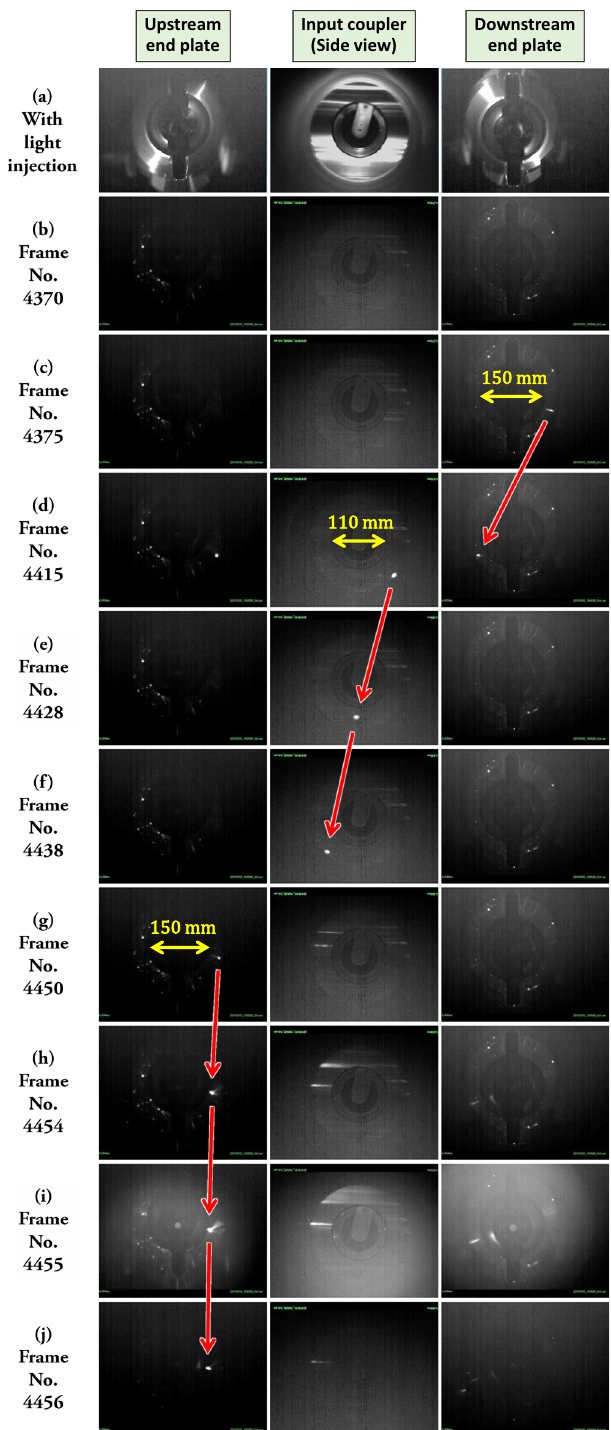
FIG. 19. First breakdown event accompanied by a flying bright object, which occurred at V c ¼ 0 . 88 MV, 15 ∶ 05 on March 15 in 2017. (a) Photographs showing the view of the high-speed cameras with light injected into the cavity for visualization. (b) – (j) Snapshots synchronized among the three high-speed cameras recorded at 1000 fps. Red arrows indicate the flying bright object of interest. The brightness of all images was enhanced by 60% relative to the original